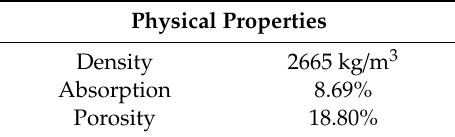
Table 6. Physical properties of the hybrid concrete (28 days).